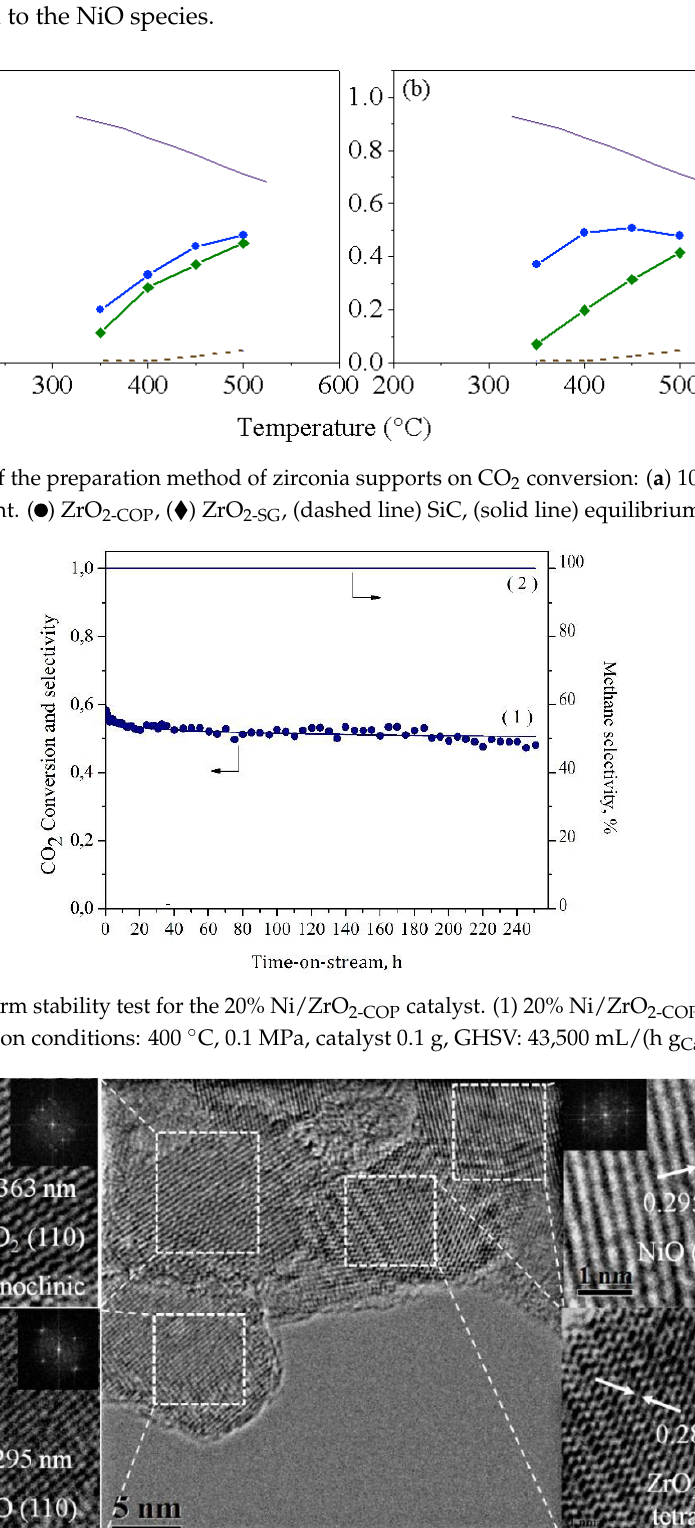
Figure 5. Effect of the preparation method of zirconia supports on CO 2 conversion: ( a ) 10% Ni content, ( b ) 20% Ni content. (  ) ZrO 2-COP , (  ) ZrO 2-SG , (dashed line) SiC, (solid line) equilibrium conversion.